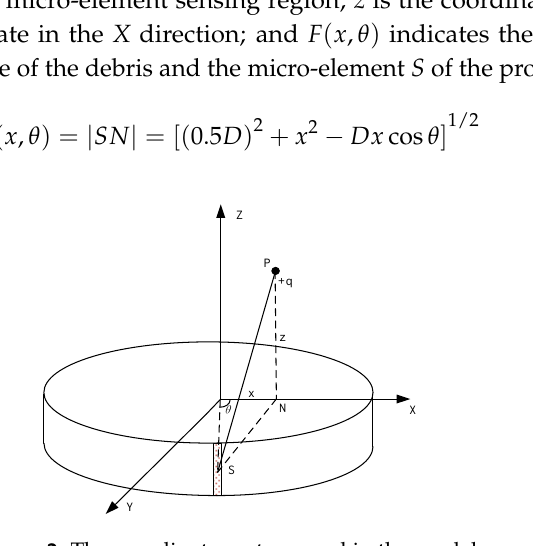
Figure 2. The coordinate system used in the model.